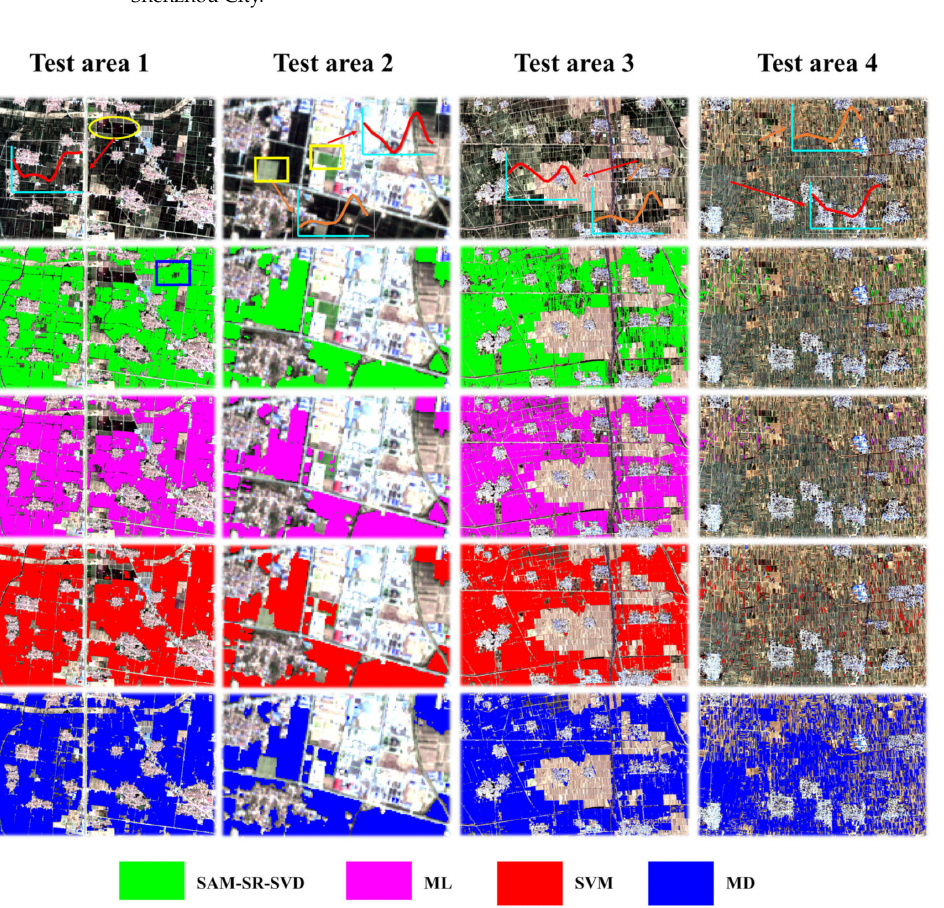
Figure 9. Comparison of local winter wheat mapping results using different methods. Test area 1–2 is selected from Puyang County, and test area 3–4 is from Shenzhou City. The marked red lines are non-winter wheat pixels, and the orange lines are winter wheat